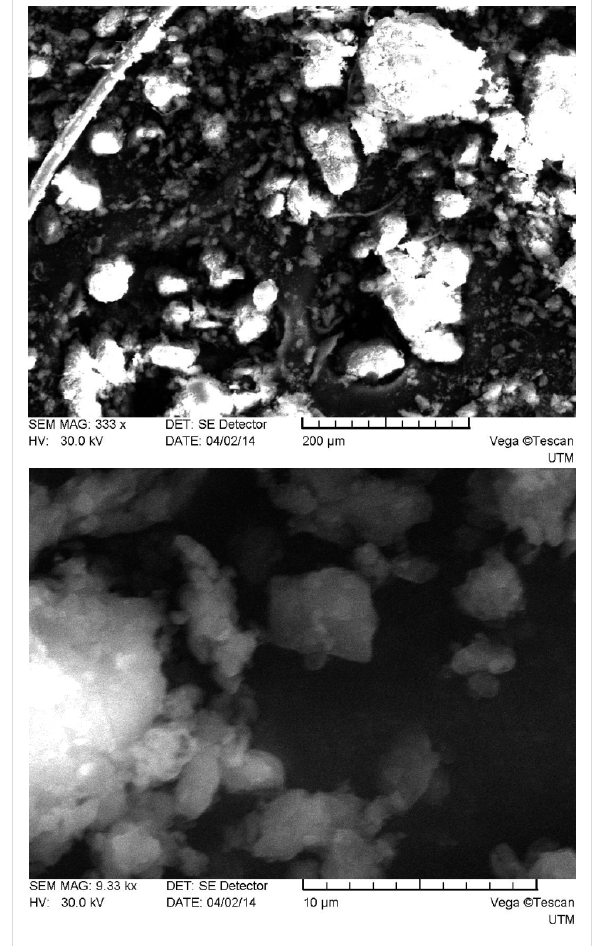
Figure 5: SEM micrographs of system 4 particles (top: magnification 326×, bottom: 12480×).